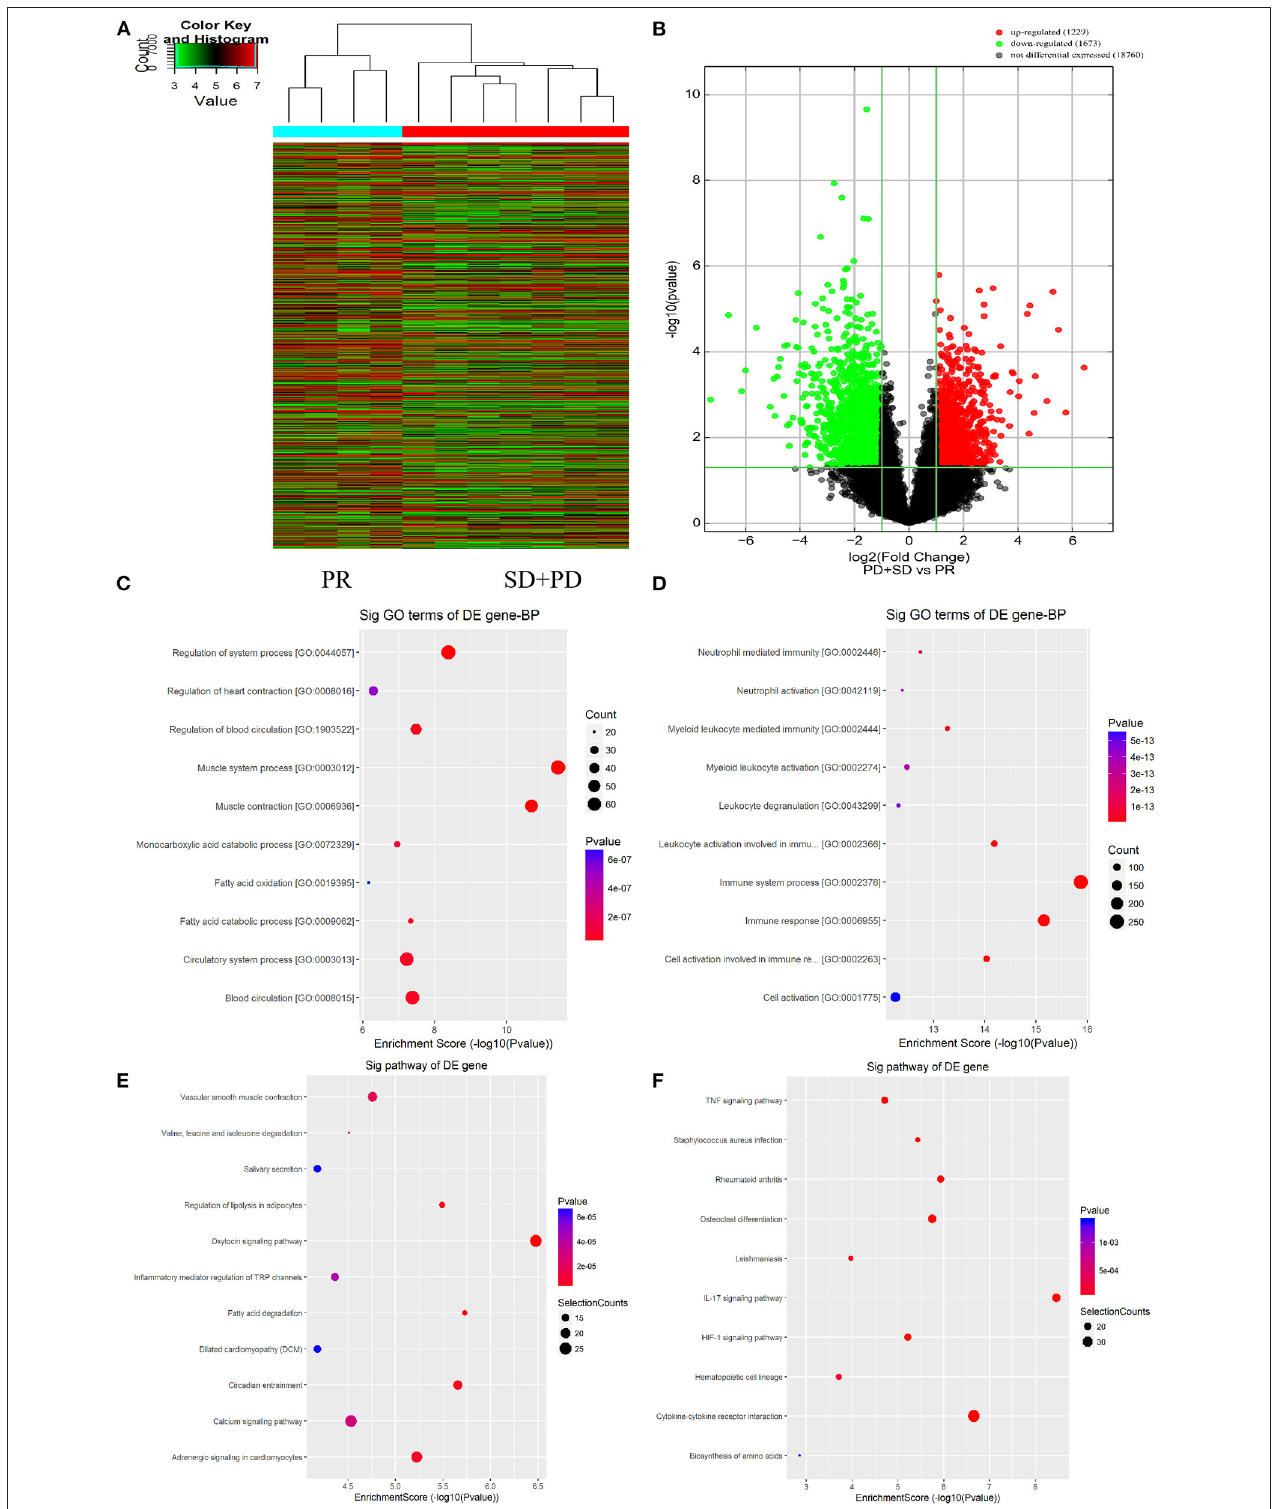
FIGURE 2 | Long non-coding RNAs (lncRNAs) expression profile comparison between chemotherapy-resistant and chemotherapy-sensitive groups. Gene Ontology (GO) functional and Kyoto Encyclopedia of Genes and Genomes (KEGG) pathway analysis of the differentially expressed genes. (A) The hierarchical clustering of all target values of lncRNA expression profiling among samples. (B) Between the chemotherapy-resistance and chemotherapy-sensitivity group. The purple dots